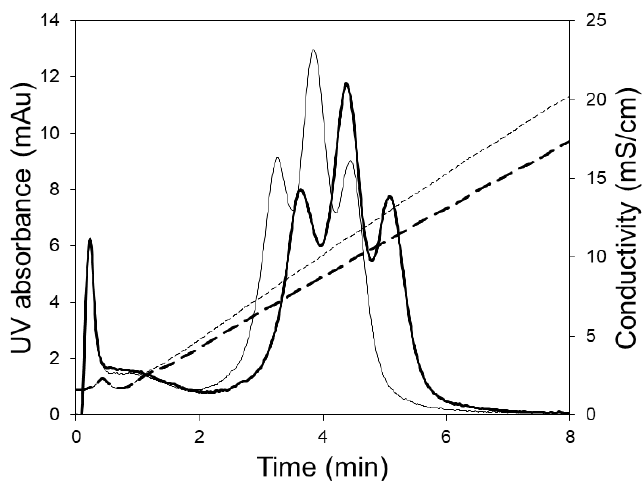
Figure 5. HIgG1-CD4 charge variant separation carried out with the LFMC device using 250 mL (thin line) and 300 mL (thick line) linear salt gradients (membrane: Sartorius S cation exchange; membrane bed volume: 4.7 mL; feed: 0.5 mg/mL HIgG1-CD4; sample volume: 2 mL; binding buffer: 20 mM sodium phosphate pH 6.0; eluting buffer: binding buffer + 0.5 M NaCl; flow rate: 15 mL/min; solid line: UV absorbance; dashed line: conductivity).